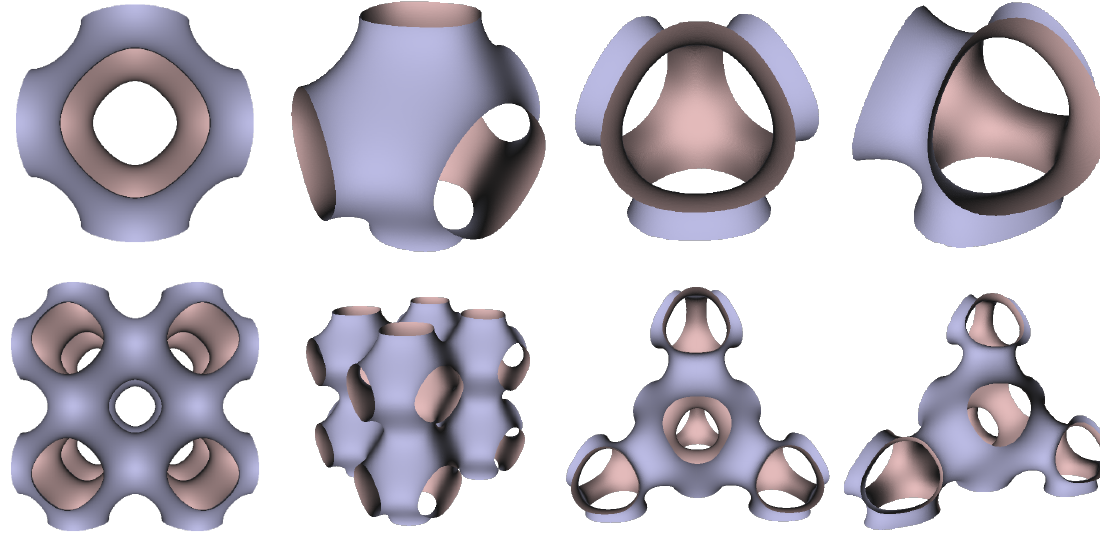
Figure 5. TPMS Schwarz P Surface (left two columns) vs. TIS P Surface (right two columns).